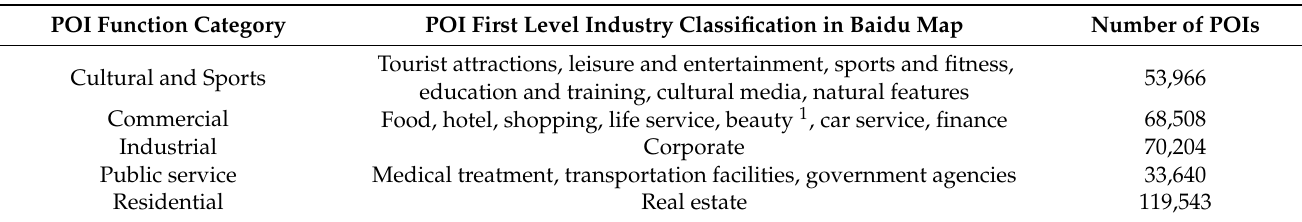
Table 1. Classification Statistics of POI in